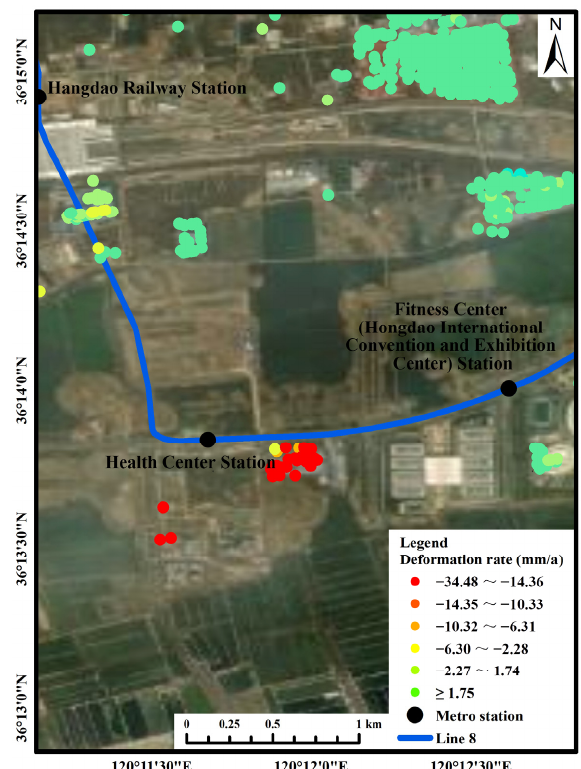
Figure 10. Deformation rate in Area A.